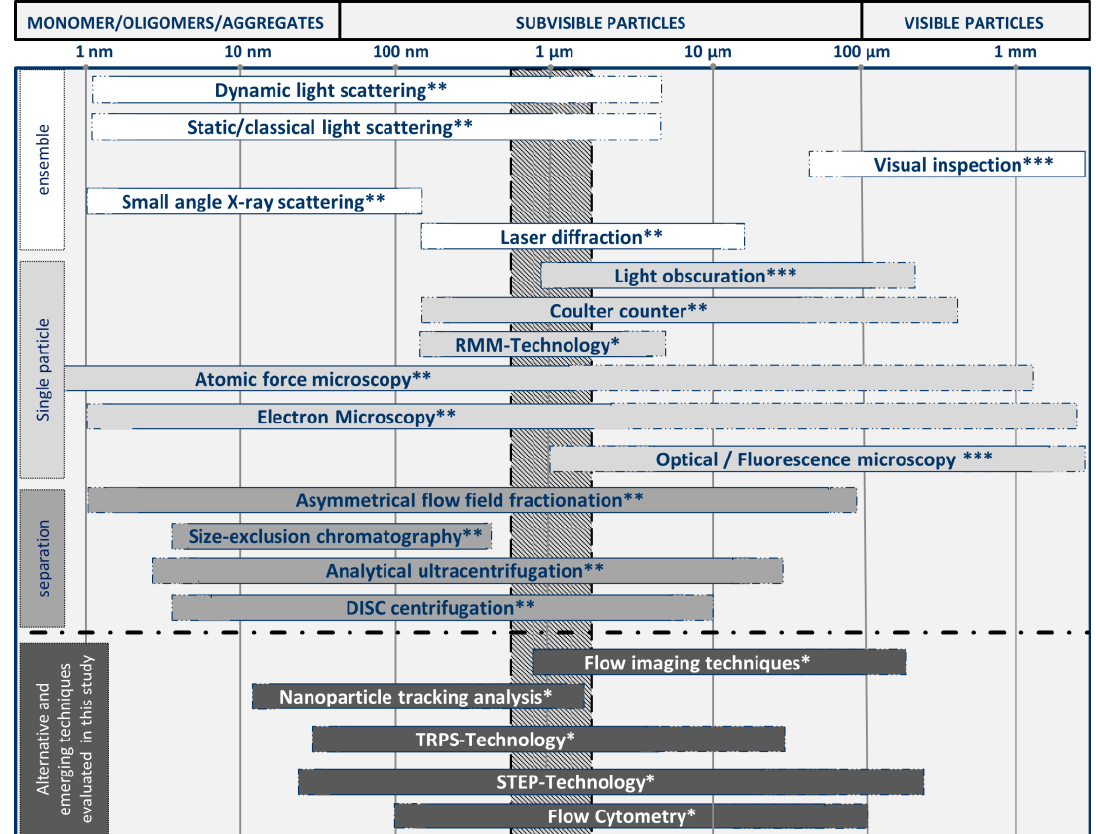
Figure 2. Overview particle detection techniques. Established (top part) and emerging (lower part) particle detection techniques are summarized according to their size measurement range. Their applicable size range is illustrated by the logarithmic scale at the top and the detection gap around 1